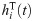
Schematic of the target-based method.Target currents hiT(t) are produced by a balanced teacher network (T, Left) driven by the desired output. The student network (Right) is trained to reproduce the target currents autonomously. We train the recurrent weights of both the excitatory (E) and inhibitory (I) populations, together with the connections between them. A linear decoder wout is trained with a standard online method (RLS) to reproduce the prescribed output target from a readout of the neurons in the network.